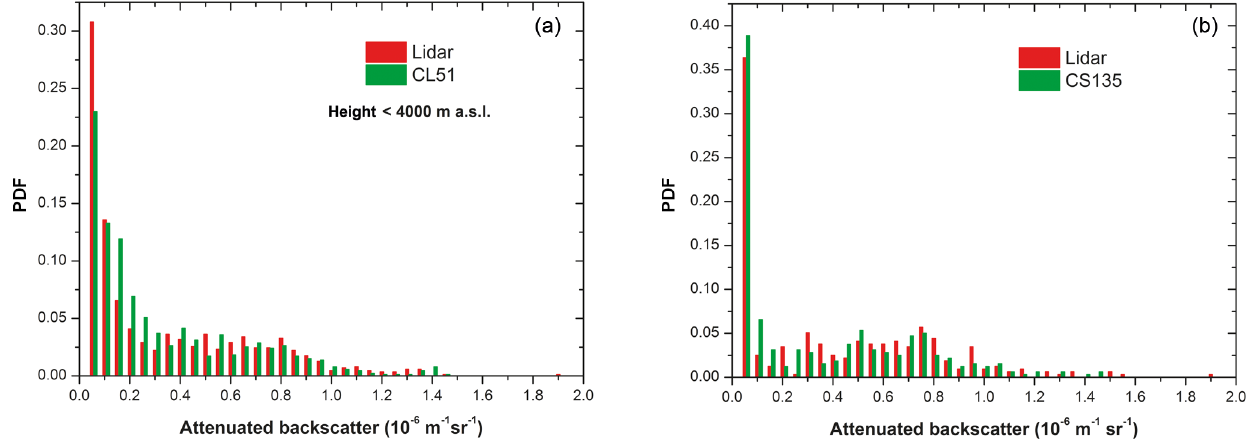
Figure 12. PDFs of the attenuated backscatter values measured or estimated by CIAO lidars and CL51 (a) and by CIAO lidars and CS135 (b) below 4km,